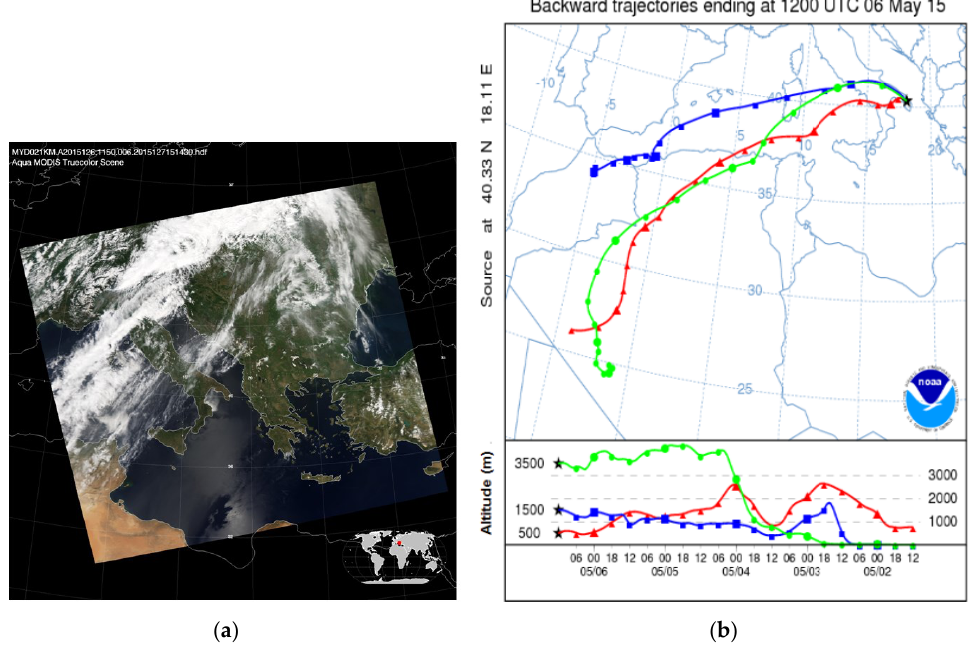
Figure 1. ( a ) True color image from MODIS (Moderate Resolution Image Spectroradiometer) on board the Aqua satellite at 11:50 a.m. UTC on 6 May 2015. ( b ) Five-day HYSPLIT (HYbrid Single Particle Lagrangian Integrated Trajectory) back trajectories that reached the monitoring site at 12:00 p.m. UTC on 6 May 2015, at 0.5 (red), 1.5 (blue), and 3.5 km (green) AGL.